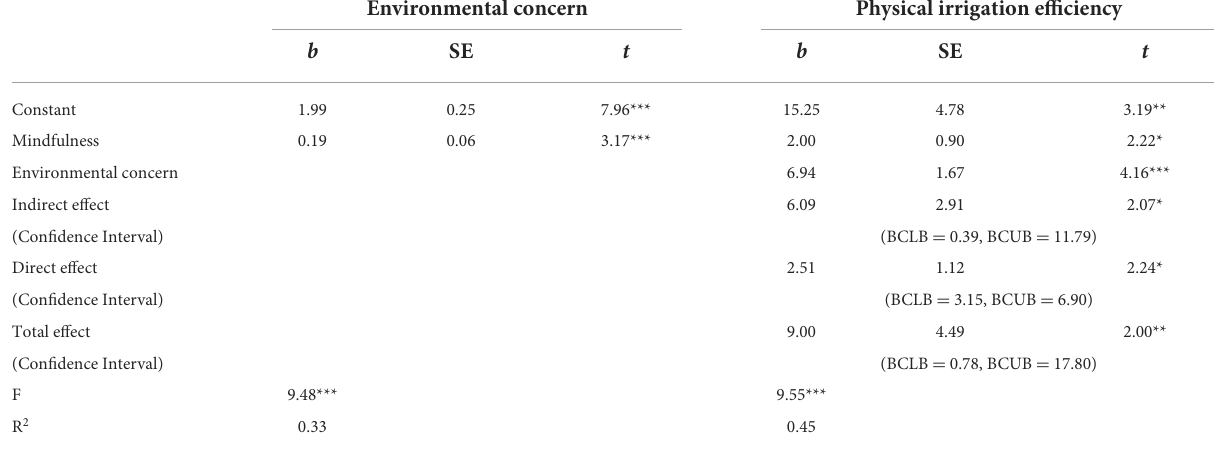
TABLE 2 Regression results for mediation